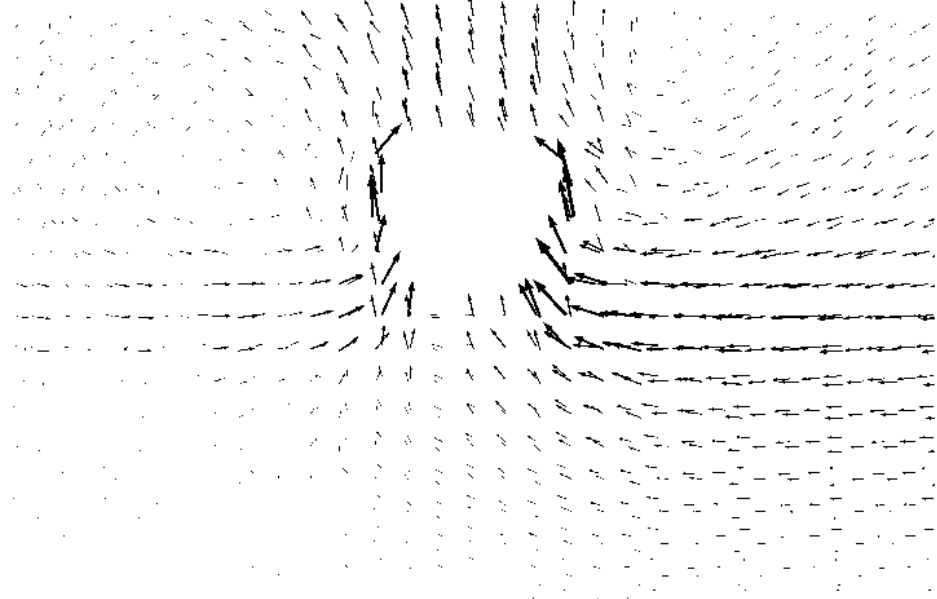
Figure 21. The contour of displacement at the embedment depth of 6 m.